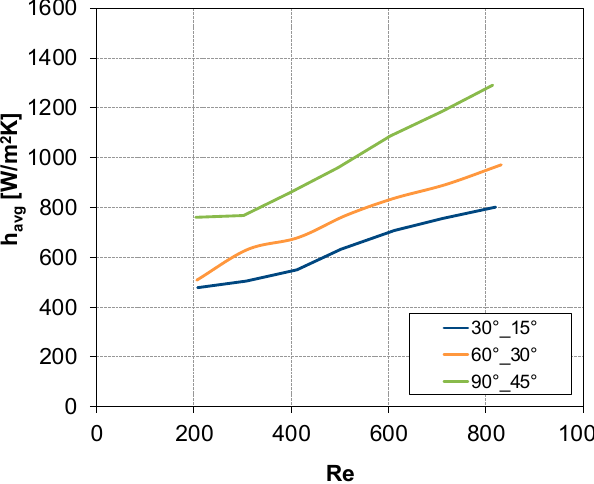
Figure 10. CFD results: h avg vs Re for θ = 30°, α = 15°; θ = 60°, α = 30°; and θ = 90°, α = 45°.